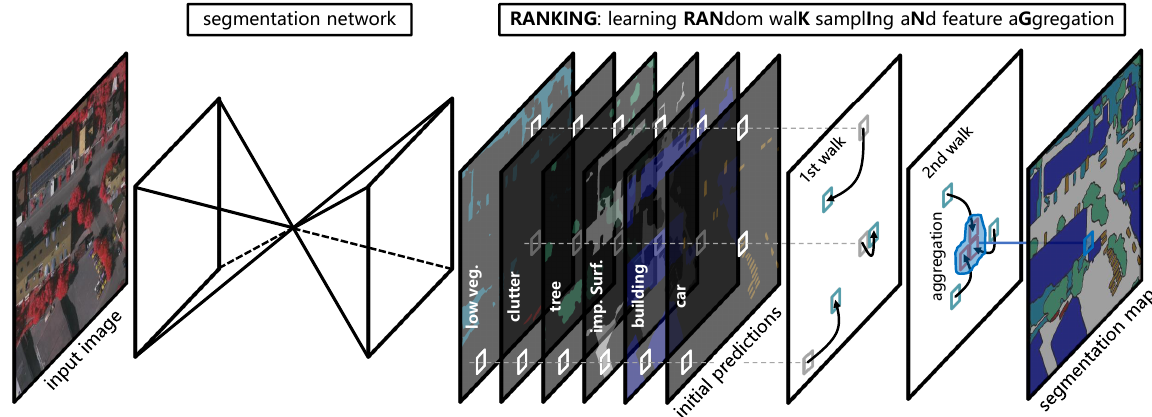
Figure 2. An overview of a RANKING-equipped fully convolutional network for aerial scene parsing tasks. The number of steps in the sampling procedure is 2 in this